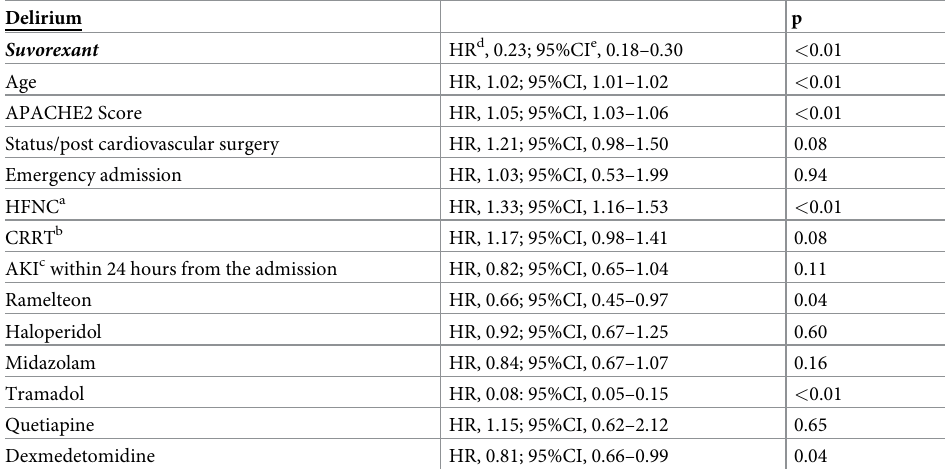
Table 1. Effect of suvorexant on delirium adjusted by covariates in “any time before” analysis. Delirium p Suvorexant